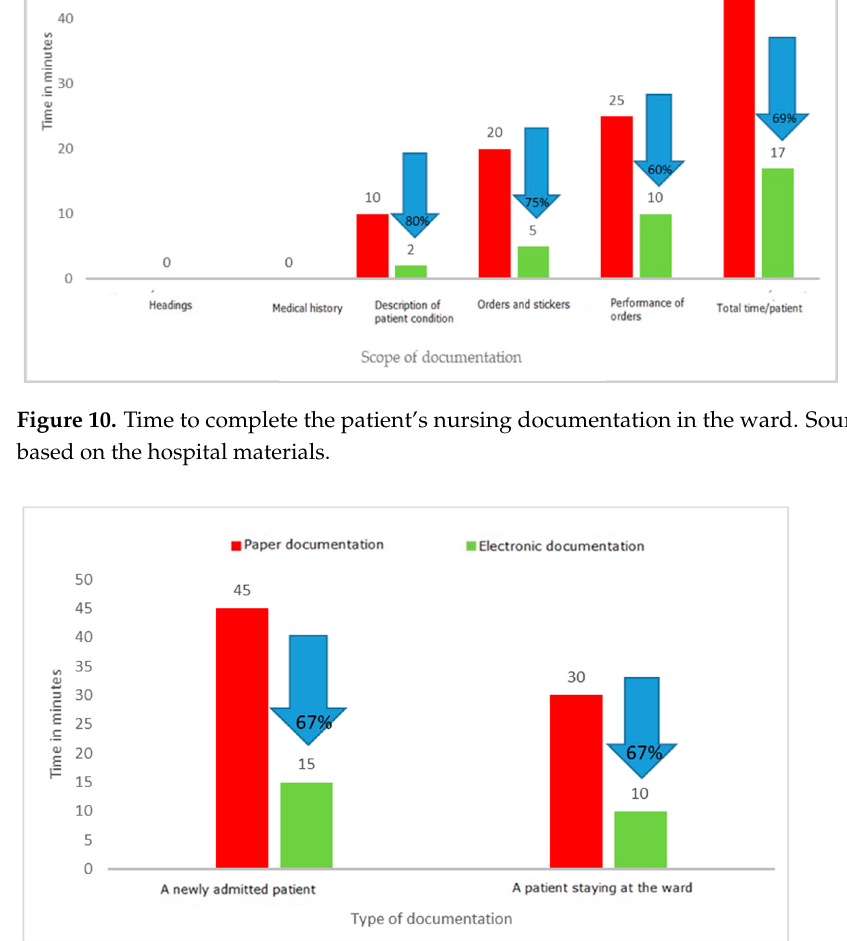
Figure 11. Time to complete the medical documentation. Source: Own study based on the hospital materials.